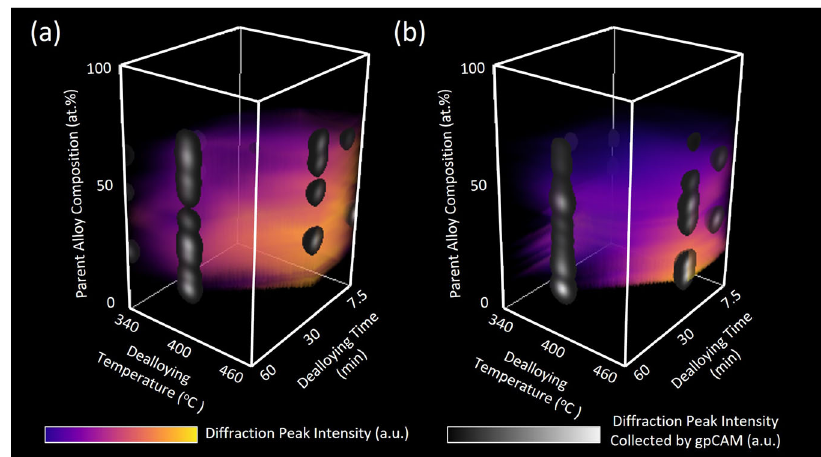
Fig. 7 The data-collection distribution of the autonomous experiment driven by the gpCAM algorithm overlayed on the interpolation of the diffraction peak intensities from Cu2Mg (3 1 1) and CuMg2 (3 5 1). a The sample with thin Mg layer, b The sample with thick Mg layer. Note that the colormap in grid-scan and gpCAM are different for better visualization. (For video sequence of diffraction peak intensity analysis see Supplementary Movie 1 –